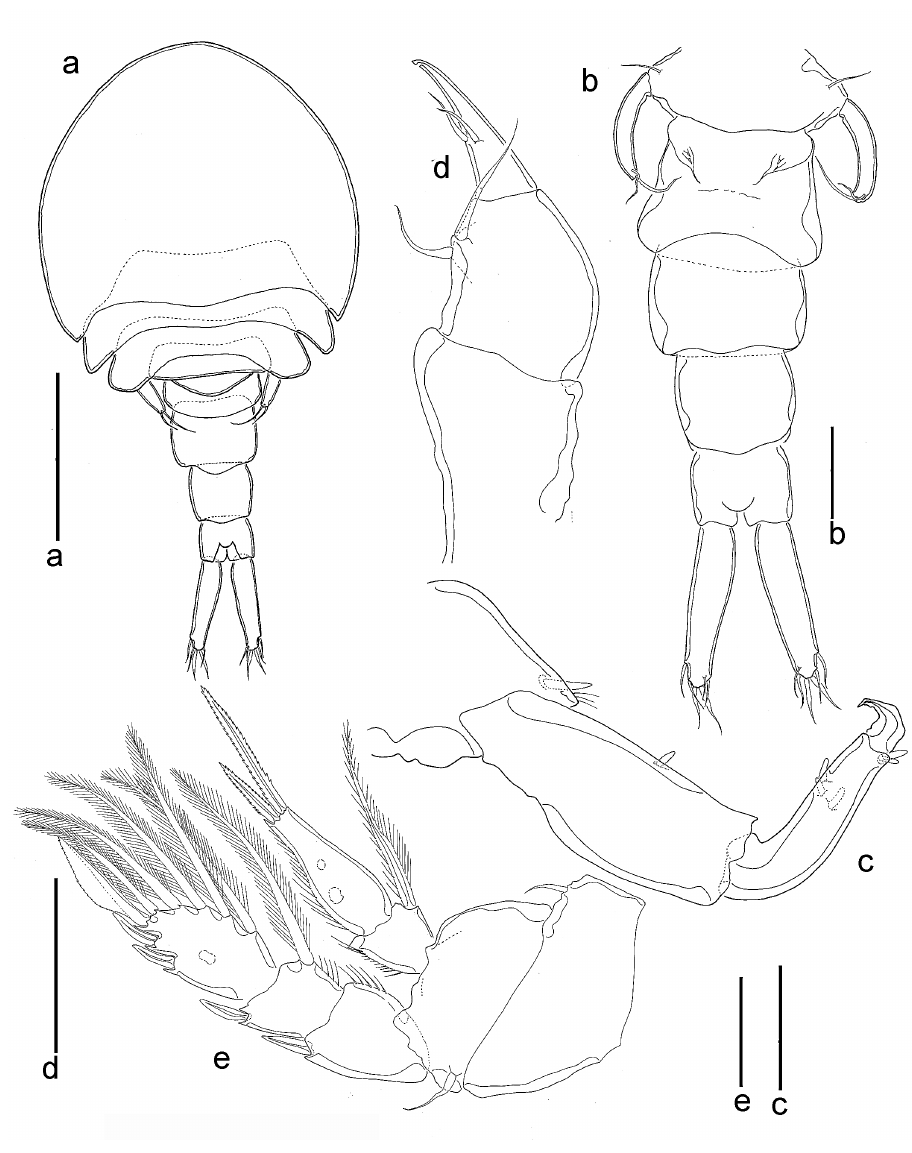
Figure 8. Spaniomolgus stylophorus sp. n., female. a Habitus dorsal b Urosome dorsal c Antenna d Maxil- liped e Leg 4. Scale bars: 300 μm ( a ); 100 μm ( b ); 50 μm( c–e ). shaped; 170 μm minimum width (anterior half), 220 μm maximum width (posterior half) and 155 μm long; shorter dorsally than ventrally. Paired genital apertures bipartite, each comprising ventrolateral copulatory pore and dorsolateral gonopore (oviduct open- ing). Each genital area with two minute spiniform setae (Fig. 8b). Egg sac unknown. Three postgenital somites 120 × 180, 120 × 130 and 94 × 110 μm from anterior to